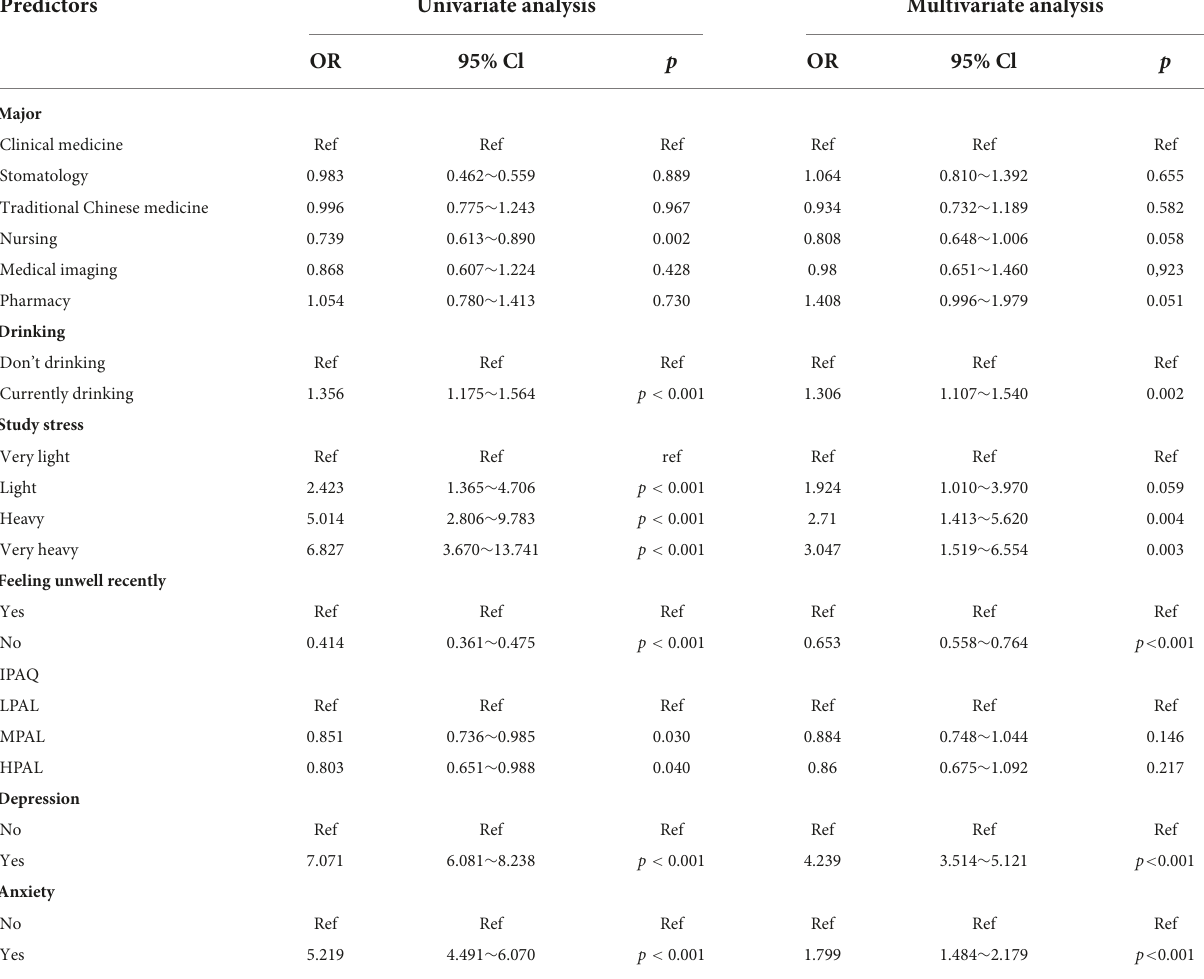
TABLE 3 Univariate and multivariate logistic analysis of risk factors for poor sleep quality among medical students. Predictors Univariate analysis Multivariate